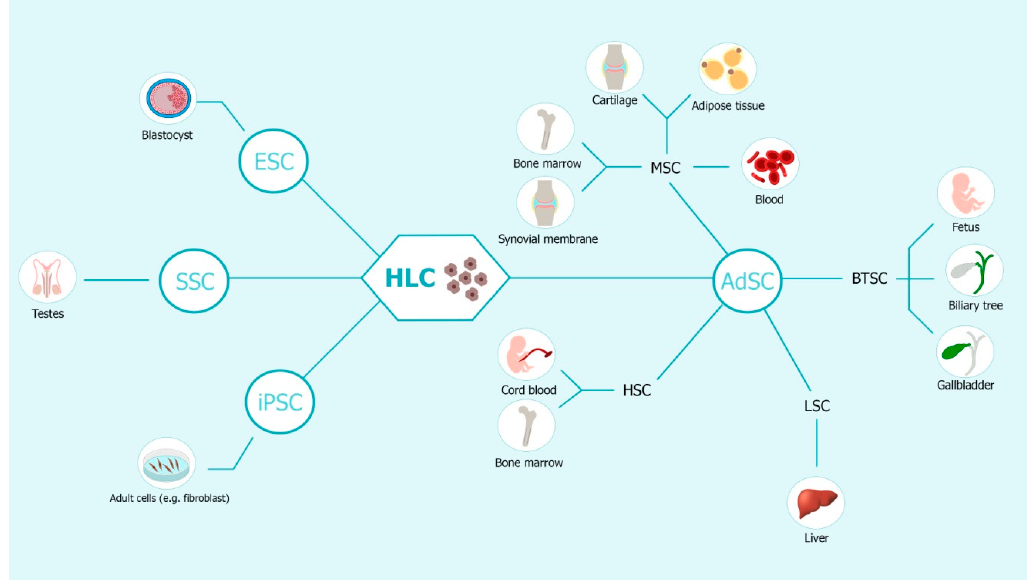
Figure 1. Sources of hepatic-like cells (HLCs) for stem cell therapy in liver disease. HLCs can be differentiated from embryonic stem cells (ESCs) derived from the inner cell mass of blastocysts, or from adult stem cells (AdSCs). The main types of AdSCs used for cell therapy are: mesenchymal stem/stromal cells (MSCs) isolated from blood, adipose tissue, cartilage, bone marrow and synovial membrane; hematopoietic stem cells (HSCs) found in the bone marrow and umbilical cord blood; biliary tree stem/progenitor cells (BTSCs) derived from the peribiliary glands of the adult and fetal human biliary tree or from the crypts of the gallbladder; endothelial progenitor cells (EPCs) taken from peripheral vessels and from bone marrow; liver stem cells (LSCs) localised in the liver. HLCs can be also obtained from induced pluripotent stem cells (iPSCs) obtained by reprogramming of adults cells by specific growth factors or spermatogonial stem cells (SSCs) derived from testis.